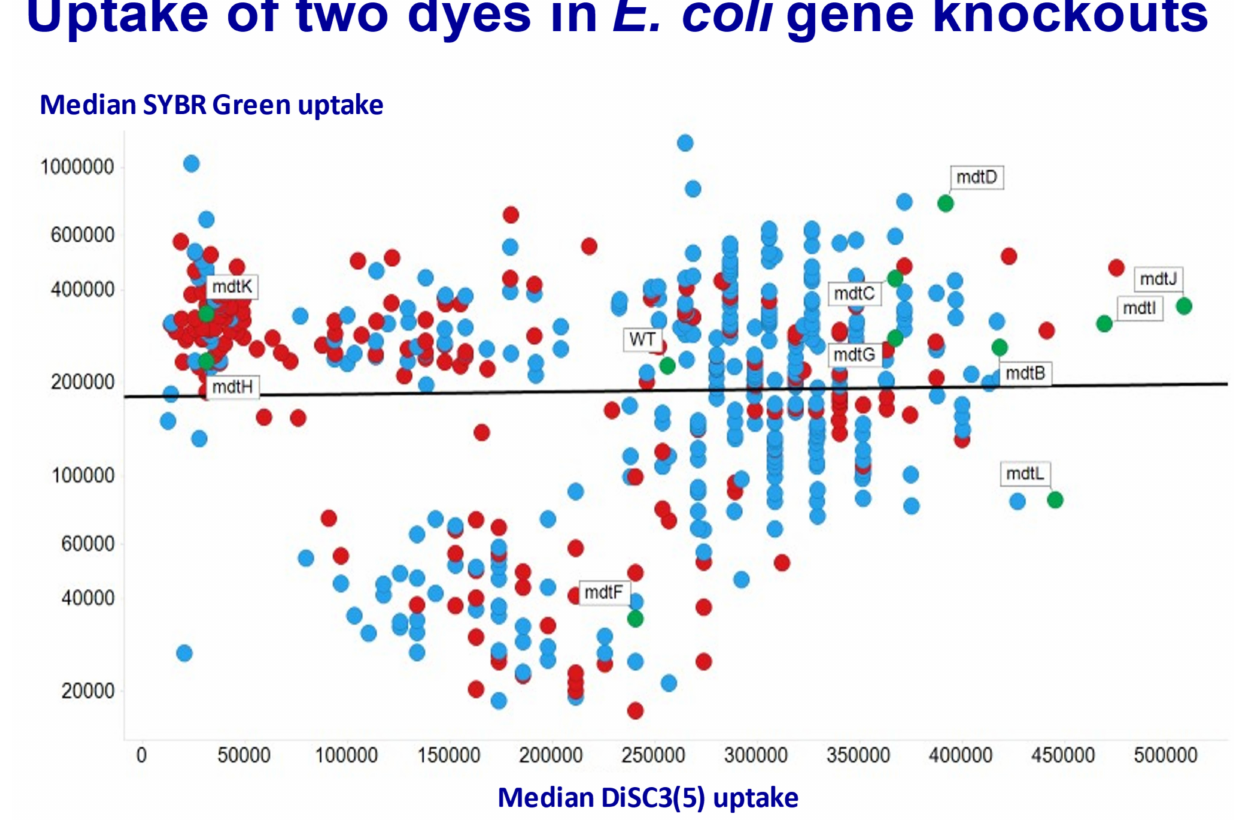
Figure 6. Dual roles of so-called multidrug transport proteins in E. coli . Data redrawn from those published with Open Access at [261]. Plotted are the median uptakes of SYBR Green and DiSC3(5) by various knockout strains relative to the Wild Type (WT). The ranges are, respectively, 70-fold and 36-fold. So-called y-genes (genes of nominally unknown function [278,279]) are encoded in red. Mdt gene knockouts are labelled (and have green